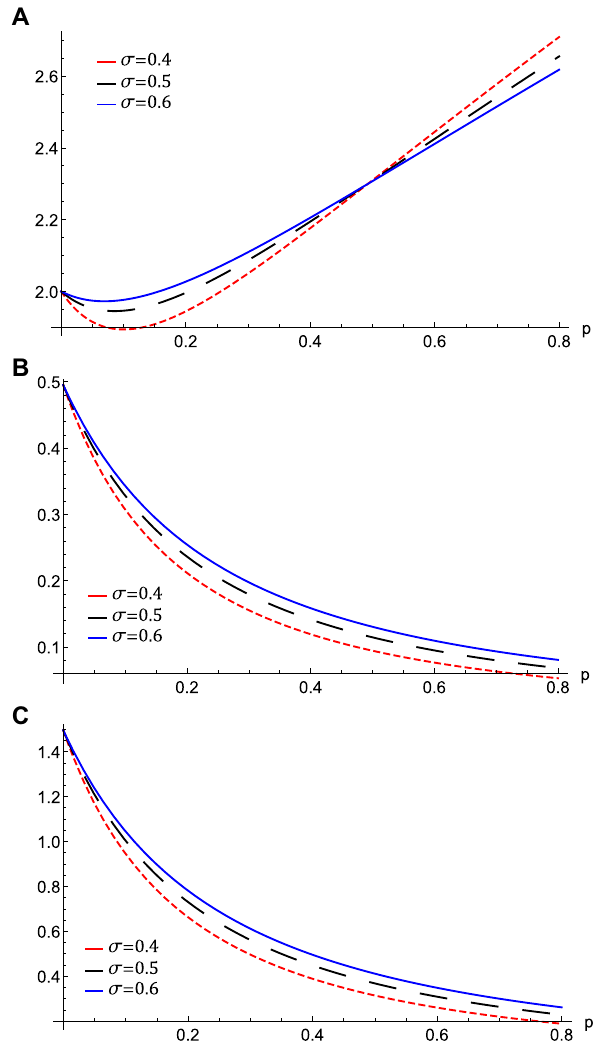
Figure 2. ( A ) The variation of the nonlinear term A , ( B ) The longitudinal dispersive term B , ( C ) The transverse dispersive term C represented by equation ( 11 ) against p for different values of σ at ω = 0.5 , θ = 20 , H e = 0.2 , and H p = 0.4